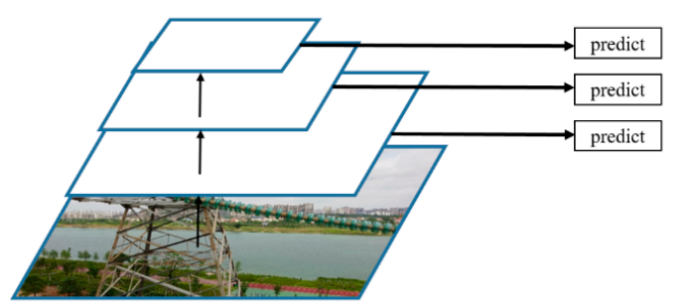
Figure 4. Multiscale prediction module in SSD.